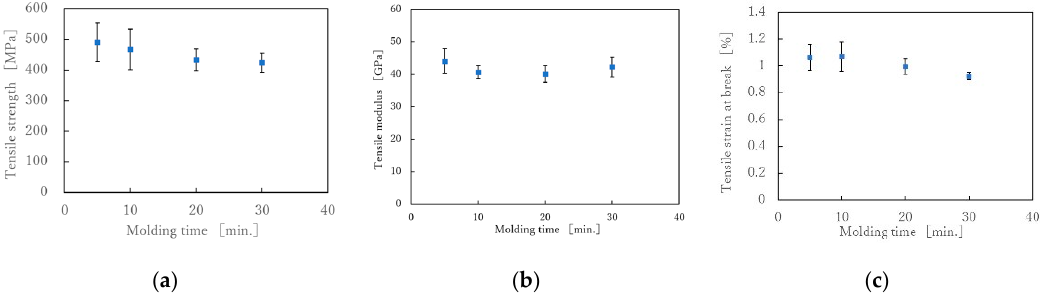
Figure 8. ( a ) Effect of molding time on tensile strength under molding pressure of 5 MPa; ( b ) Effect of molding time on tensile modulus under molding pressure of 5 MPa and ( c ) Effect of molding time on tensile strain at break under molding pressure of 5 MPa.